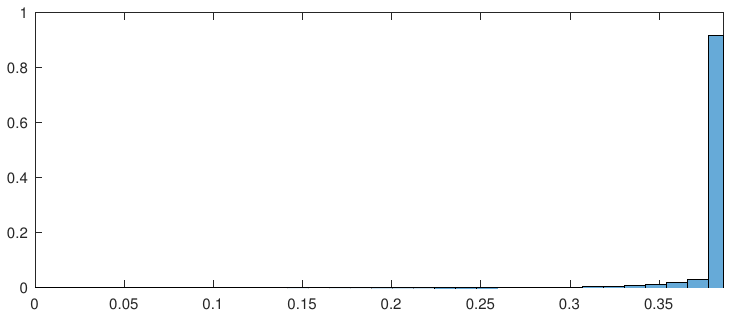
Figure 6. Distribution of the optimal release into Tana-Beles link.